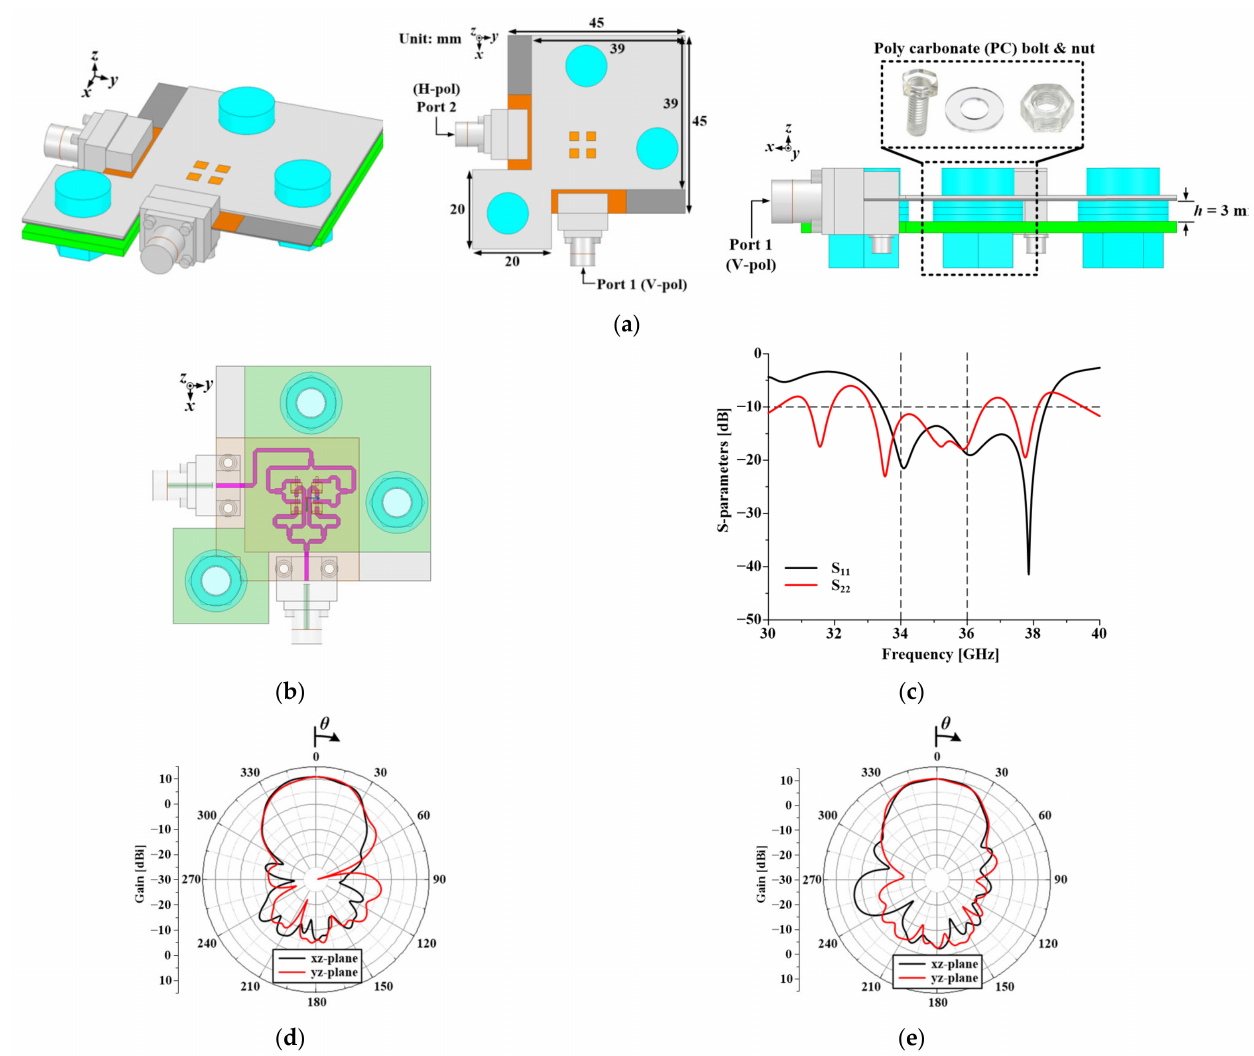
Figure 6. Assembled 2 × 2 patch antenna array: ( a ) geometry of antenna array, ( b ) perspective view, ( c ) simulated reflection coefficient performances, ( d ) simulated radiation patterns at 35 GHz when Port 1 is excited, and ( e ) simulated radiation patterns at 35 GHz when Port 2 is